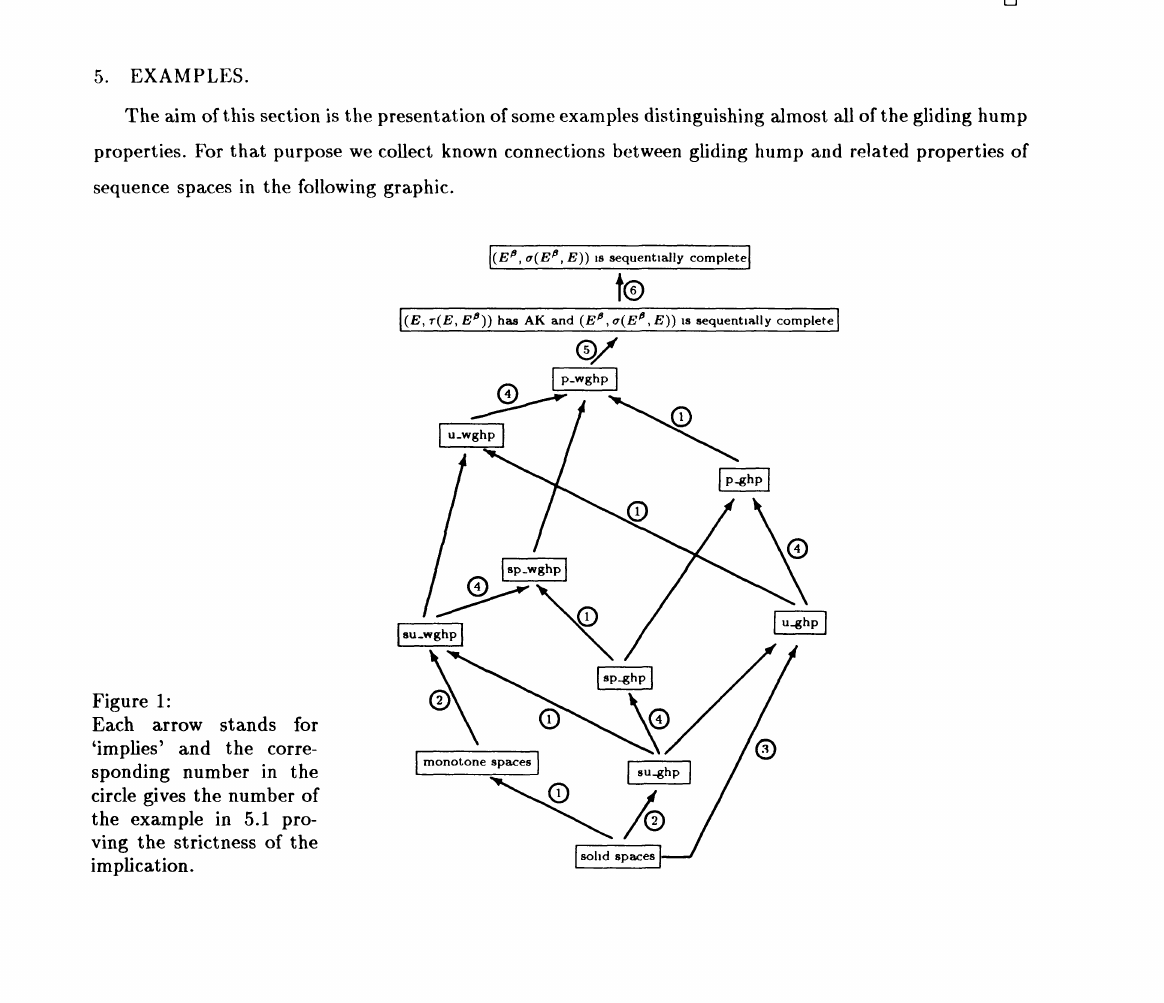
Figure 1: Each arrow stands